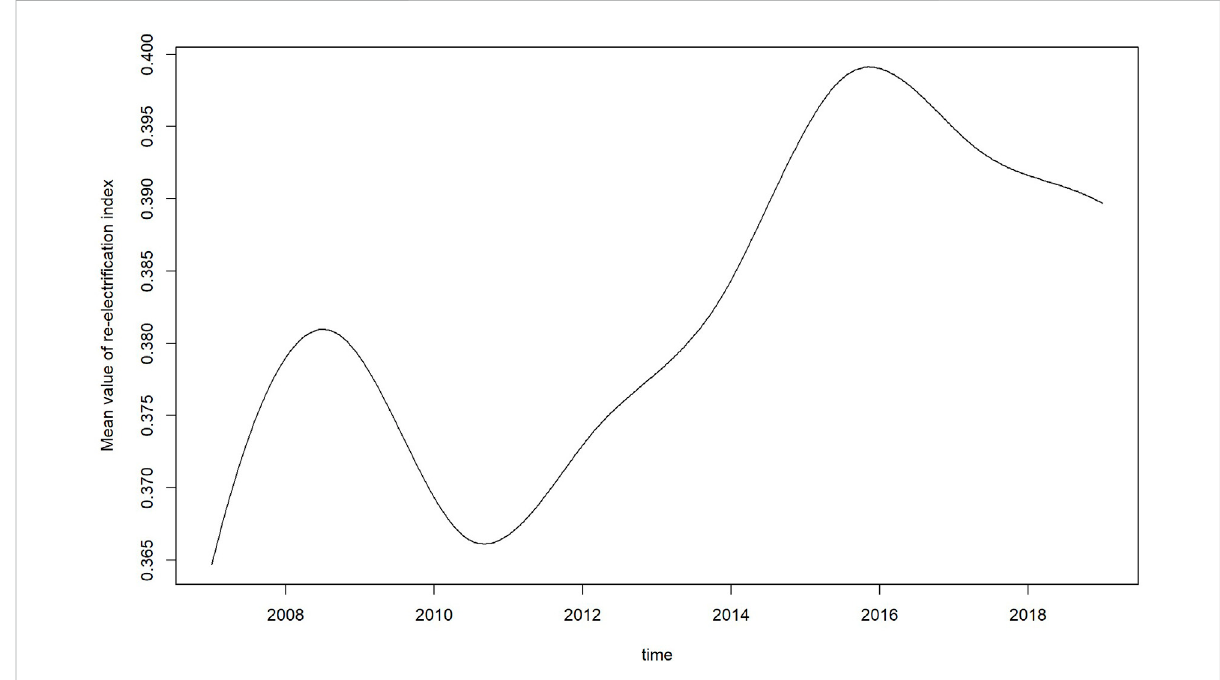
FIGURE 4 Function curve of the re-electri fi cation index mean